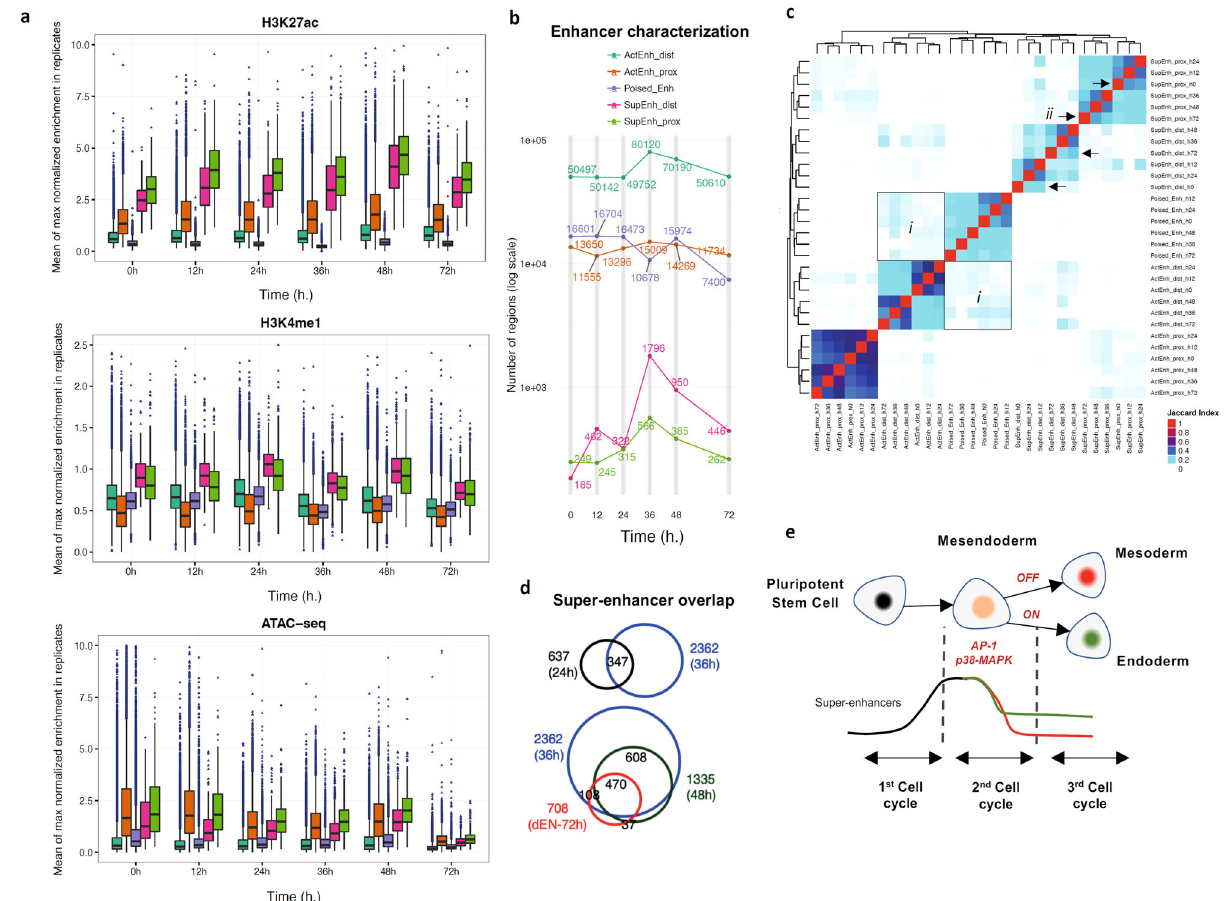
Fig. 6 | Epigenome dynamics upon differentiation reveal super-enhancers assemblyandlosstoestablishanewcellularidentity.a DistributionofH3K27ac, H3K4me1 and ATAC-seq signal in the enhancer regions shown in ( b ). The boxes show the interquartile range, with the median marked as a heavy horizontal band. Whiskersrepresentthehighest(lowest)datapointwithin1.5timestheinterquartile range of the 75th (25th) percentile. Statistical outliers are plotted separately as individual points beyond the whiskers on the boxplot. n =2 biologically indepen- dent samples. b Enhancer classi fi cation during endoderm differentiation: ActEnh_dist (H3K27ac+, H3K4me1+, H3K4me3 − , <3kb); ActEnh_prox (H3K27ac+,